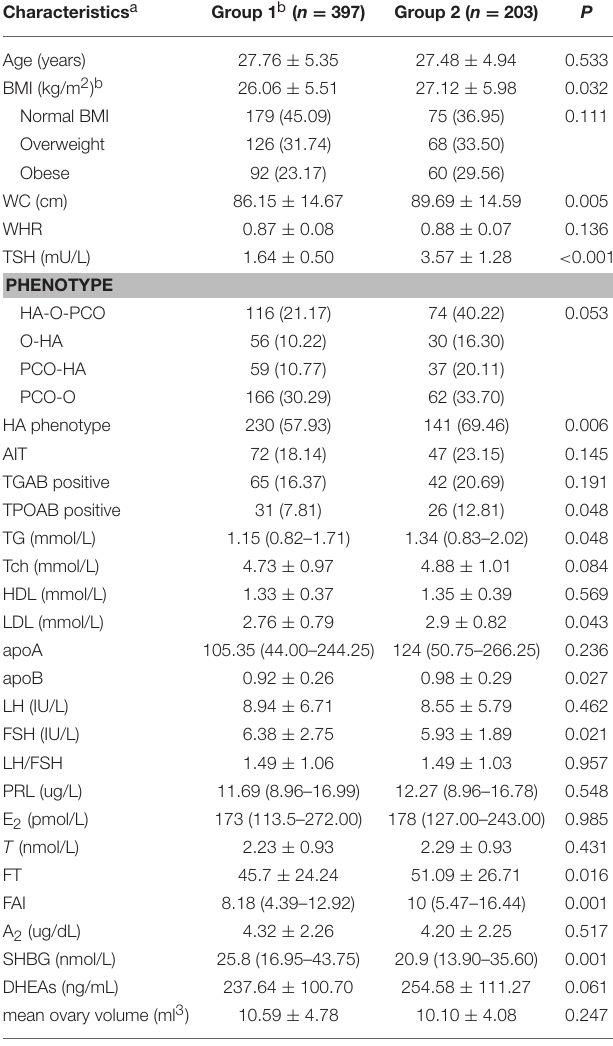
TABLE 2 | Clinical and biochemical characteristics in PCOS patients grouped by TSH level.